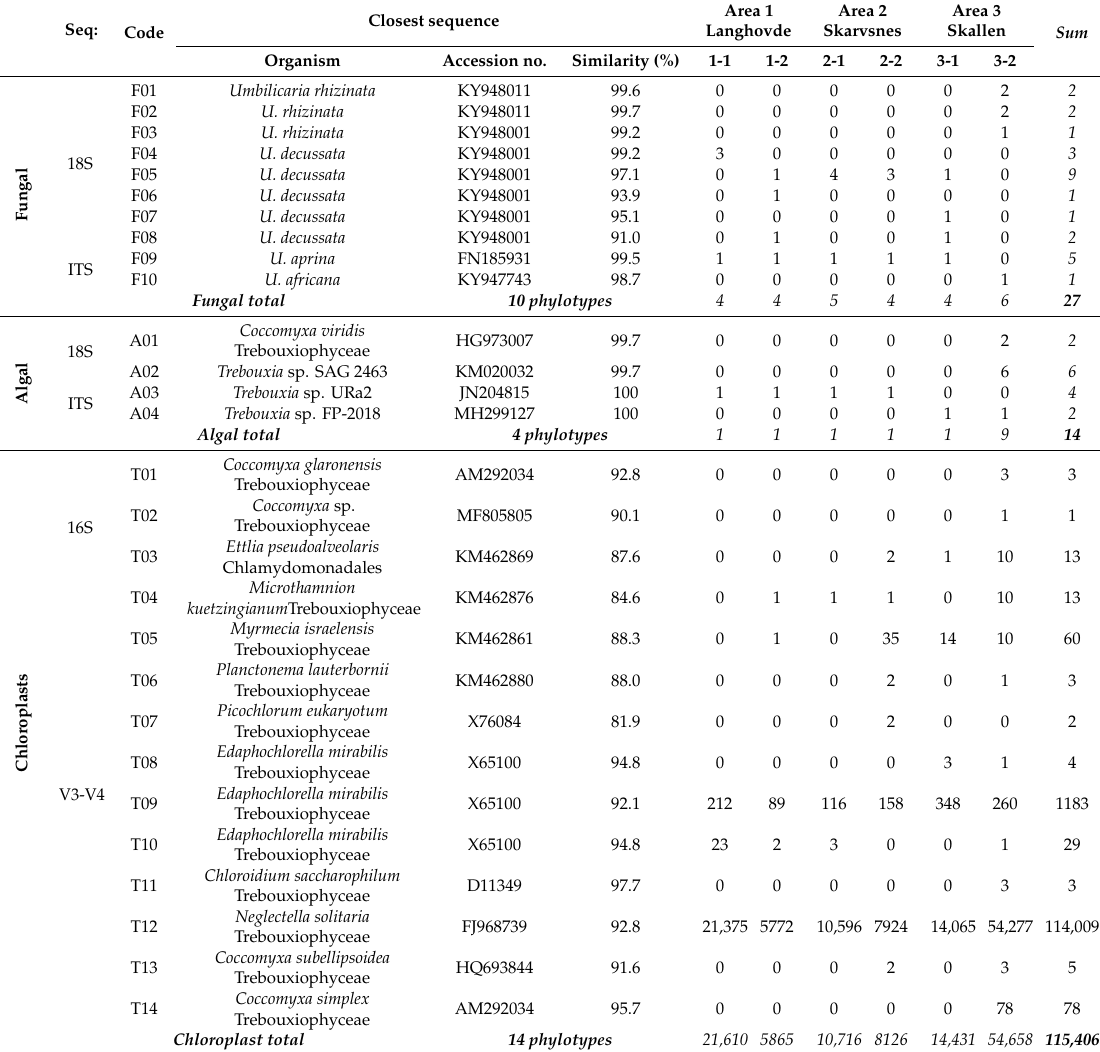
Table 4. Distribution of the numbers of phylotype-composing sequences (overall total 116,937) in lichen